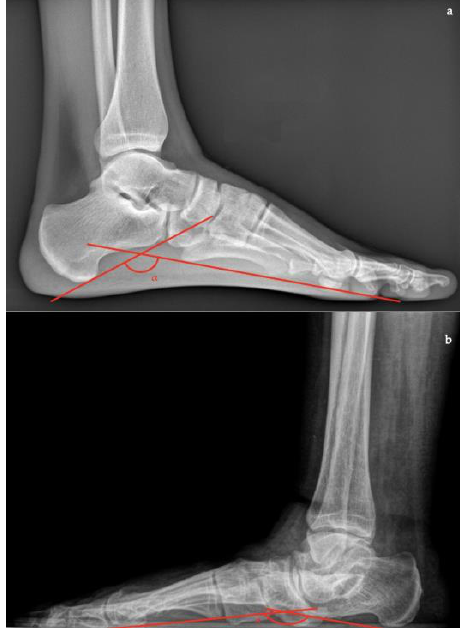
Figure 8. Calcaneal-fifth metatarsal angle (defined as the angle formed between the tangent to the inferior aspect of the calcaneus and a line drawn along the inferior aspect of the base and head of the fifth metatarsal) in the lateral X-ray view. ( a ) Normal foot, 145°; ( b ) pathological flatfoot, 175°.